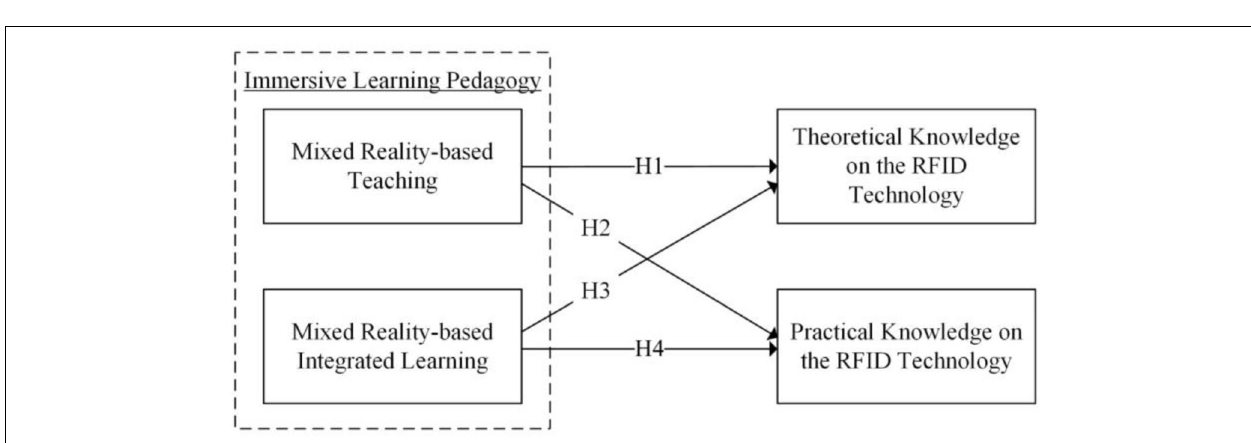
FIGURE 3 | Hypothetical model of the immersive learning